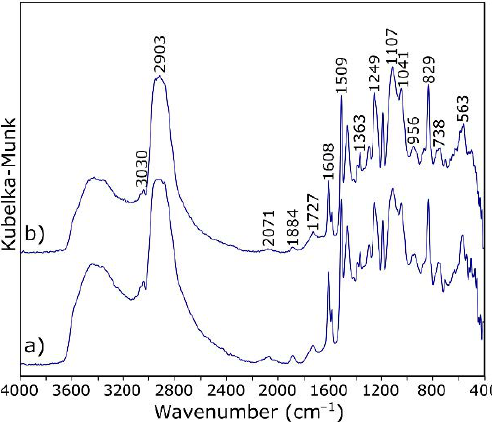
Figure 9. DRIFT spectra of ( a ) the carbon fiber reinforced polymers (CFRP) sample and ( b ) the CFRP sample with 0.3% GO addition.